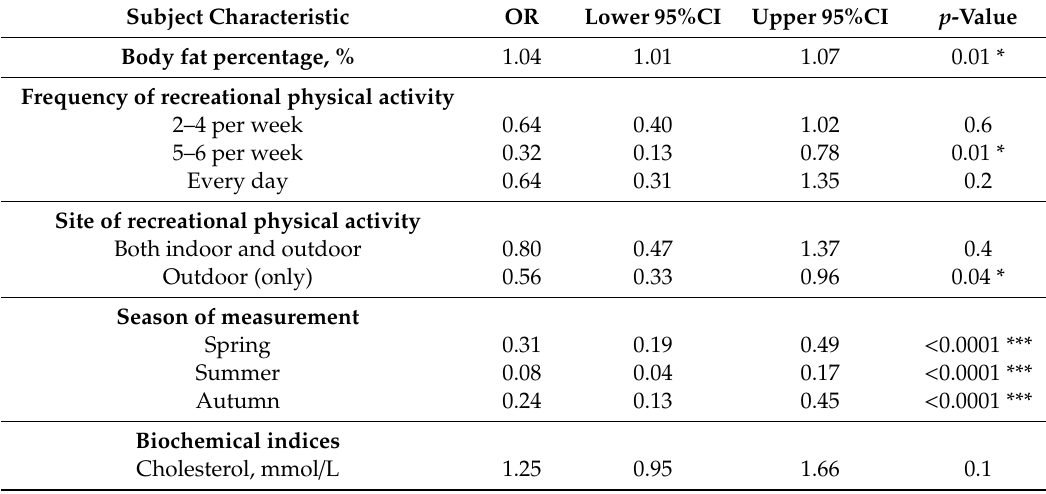
Table 4. Odds ratios (ORs) of 25-hydroxy-vitamin D insu ffi ciency and corresponding 95% confidence intervals (CIs) as derived from the best Akaike information criterion-selected multiple logistic regression model. The original model included the following variables: body mass index, body fat percentage, mid-upper arm circumference, waist circumference, frequency of recreational physical activity, duration of recreational physical activity session, site of recreational physical activity, season, frequency of alcohol consumption, smoking, cholesterol and